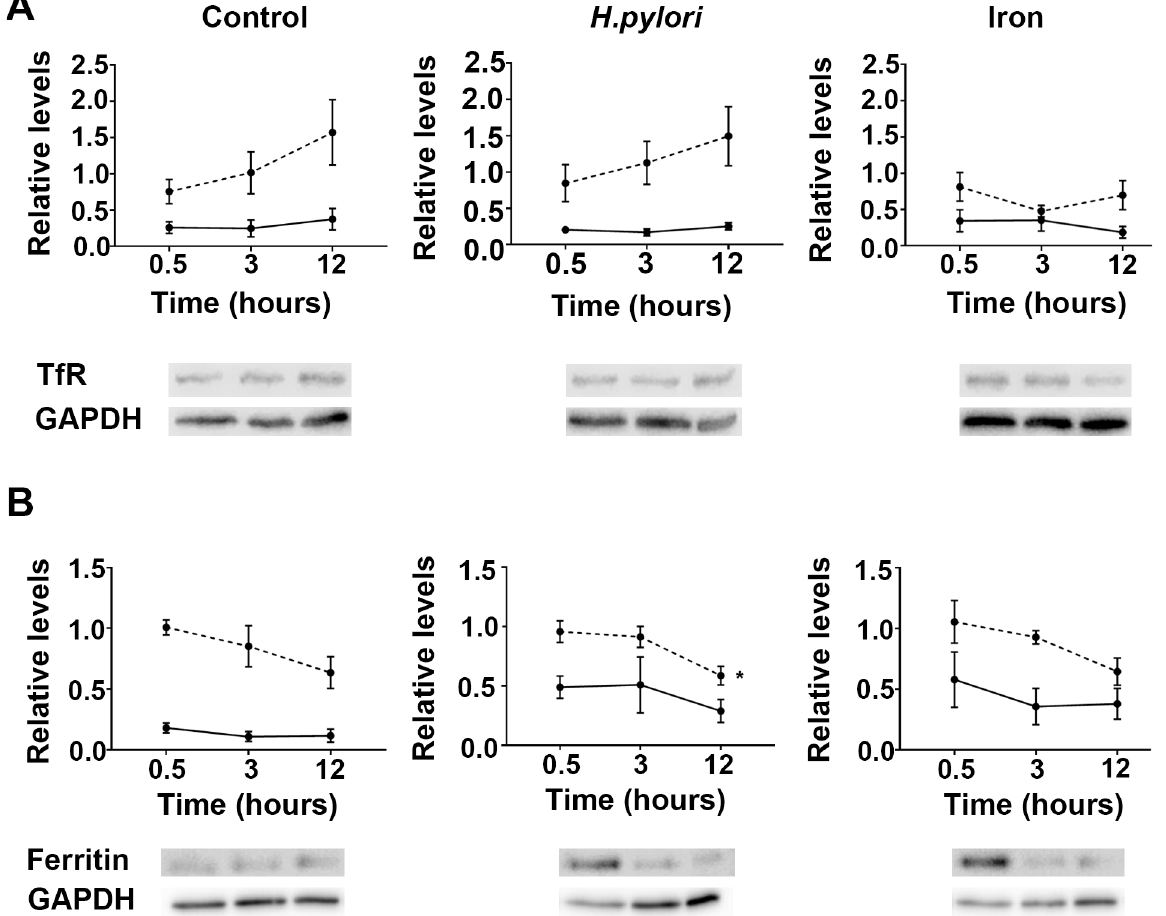
Fig 1. Quantification of transferrin receptormRNA and protein in AGS cells infected with H . pylori . Cells were infected with wild type H . pylori strain 60190 (MOI, 10:1) or supplemented with 100 μ m iron sulphate, with (A) transferrin receptor (TfR) and (B) H- ferritin mRNA (dotted line) and protein levels (solid line) quantitatedthroughout 12 h of infection. Levels are expressedas the amount of RNA and protein relative to endogenous controls HPRT and GAPDH, respectively, with representative immunoblots shown below the graphs. Data points for mRNA levels represent the averageof three experiments each done in triplicate, whereasdata points for protein represent ± SEMs for three independent immunoblotting experiments. * , levels over time are statisticallydifferent (P < 0.05),as determinedby one-wayANOVA with Tukey’s test for